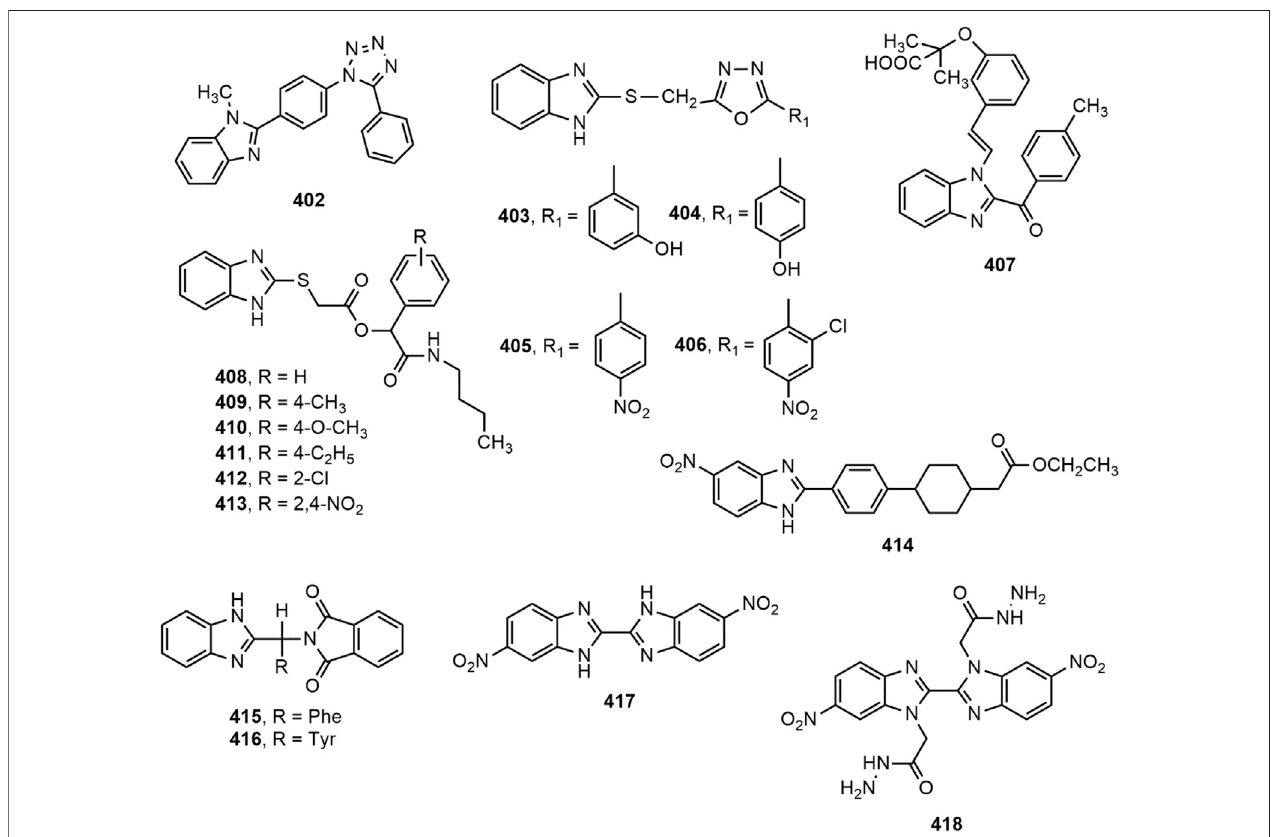
FIGURE 17 | Benzimidazole derivatives with antidiabetic